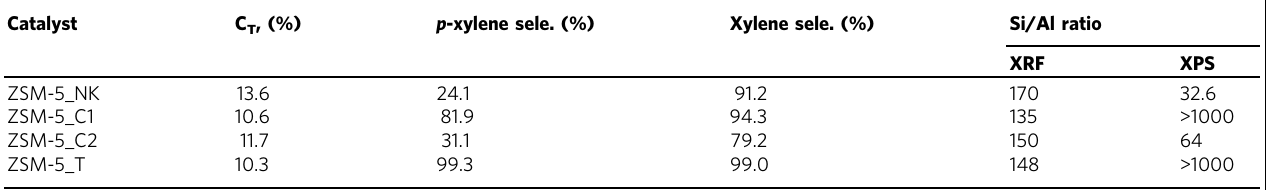
Table 1 Catalytic performances of HZSM-5 with different aluminium distribution properties to produce p